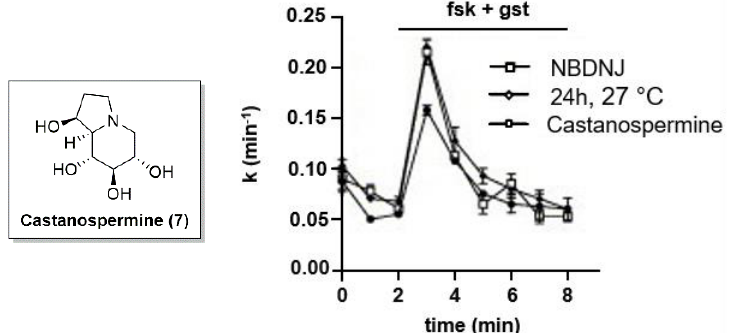
Figure 4. Rescue of functional F508del-CFTR (deletion of F508 residue in the cystic fibrosis transmembrane conductance regulator) activity by NBDNJ, low temperature or 7 as resulting by iodide efflux experiments. This figure is adapted with permission from [75].